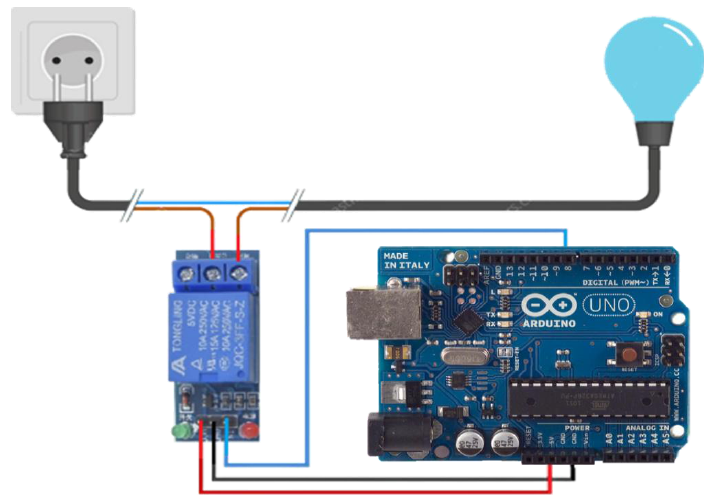
Figure 5. The control circuit for the operation of lighting and sockets in the smart home.